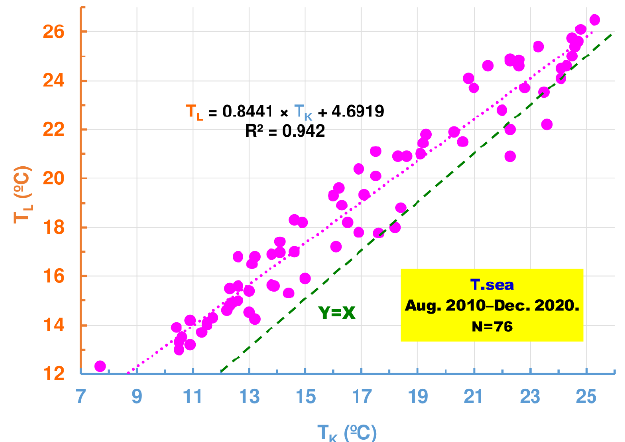
Figure 10. Relationship and trend between the pairs of the mean monthly sea surface temperatures at Lastovo (ordinate axis) and Krk (abscissa axis) from July 2010 to December 2020, when measured at both stations.